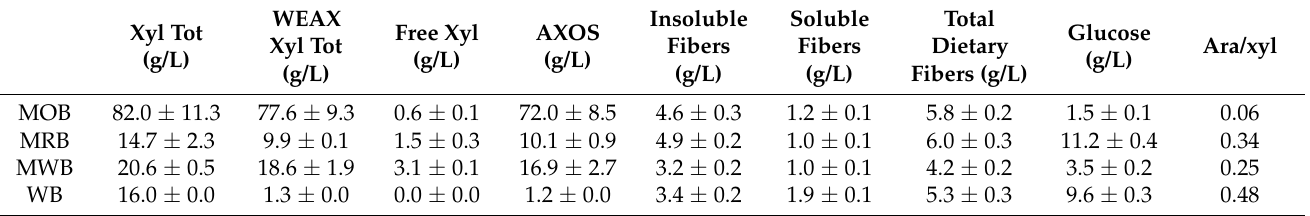
Table 1. Composition of four formulations containing AXOS (MOB, MRB, MWB and WB). Details on the production of AXOS formulations were provided in the Material and Methods